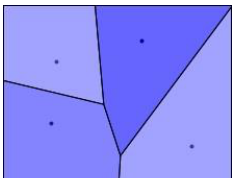
Figure 1. Basic Voronoi diagram with four data points. The area is divided in four cells of points, that are closest to each data point. The size of the cells is limited by a predefined rectangular area, the bounding box. We would like the cells to be restricted by a maximum size rather than a predefined rectangle.